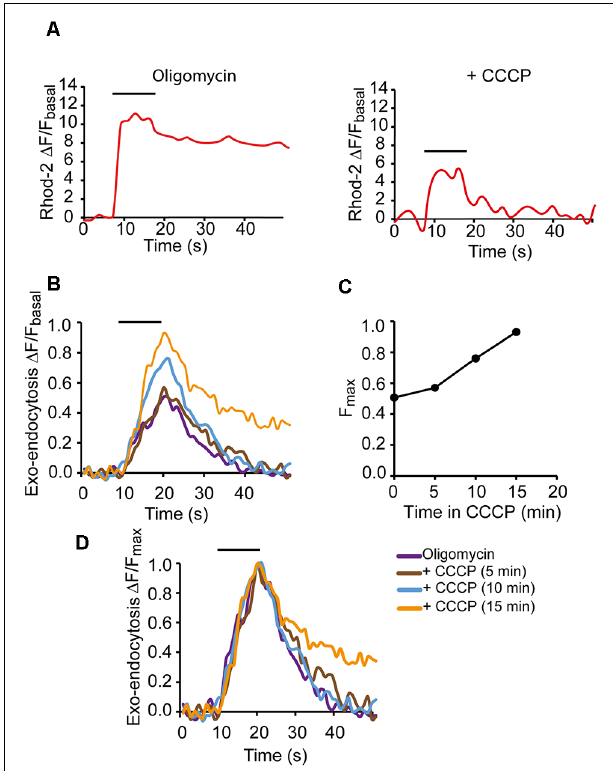
FIGURE 4 | Modification of the secretory response in depolarized mitochondria. (A) mCa 2+ responses to 500 AP stimulation (50 Hz) in oligomycin only solution (left graph) and with oligomycin plus CCCP (right graph). (B) SypHy fluorescence increases in oligomycin alone (purple trace) and after 10 and 15 min in oligomycin plus CCCP (blue and yellow traces, respectively). Fluorescence increments were represented relative to the basal fluorescence in each case. (C) Fluorescent peak amplitudes of the SypHy signals vs. time in CCCP. (D) SypHy fluorescence for recordings in (B) normalized to their respective peak values to compare the kinetics of the responses. Horizontal lines show the start and end of the stimulation train (500 AP, 50